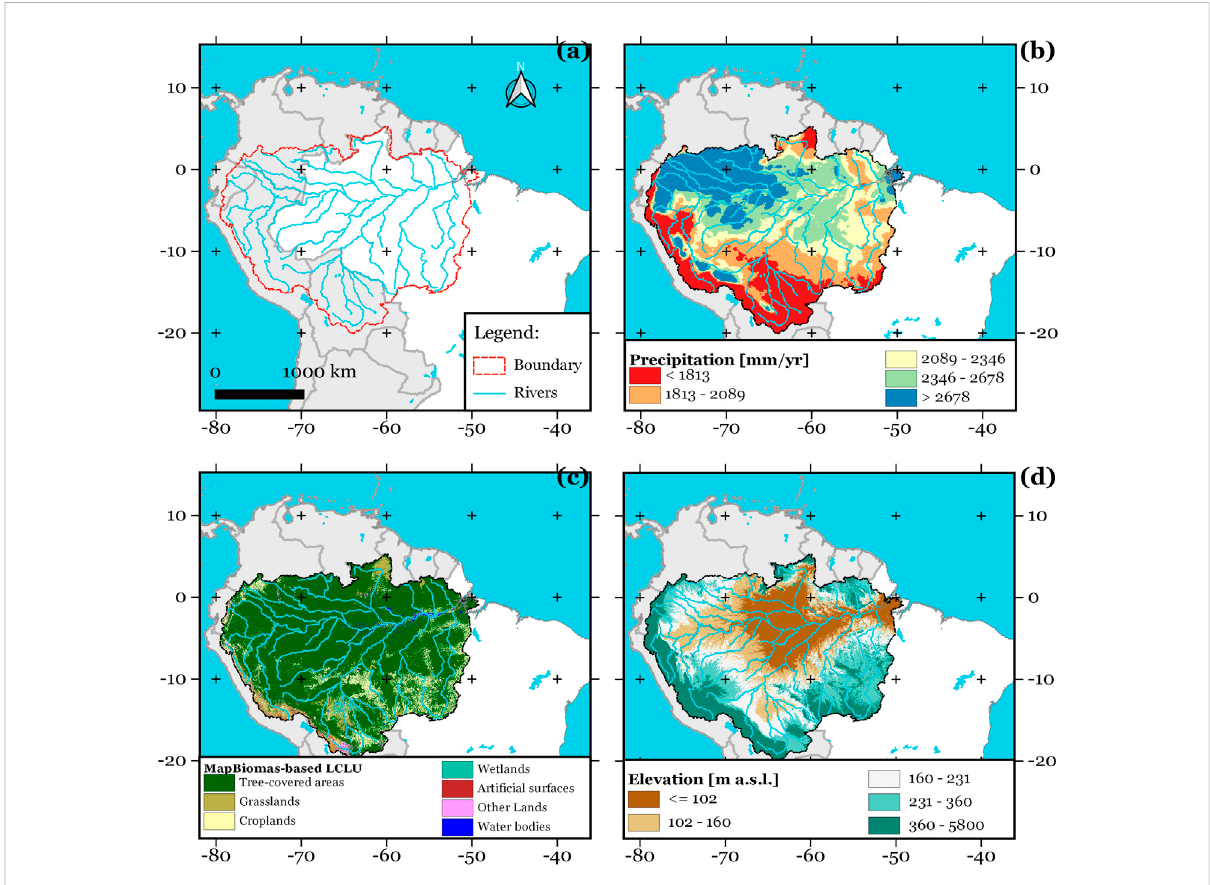
FIGURE 1 The study area. Map of (A) the hydrographic network; (B) mean annual precipitation from the CHIRPS dataset for the period 2000 – 2018; (C) LCLU from MapBiomas at 2020 aggregated to the UNCCD classes (Sims et al., 2019); (D) terrain elevation according to the Shuttle Radar Topographic Mission (Jarvis et al.,